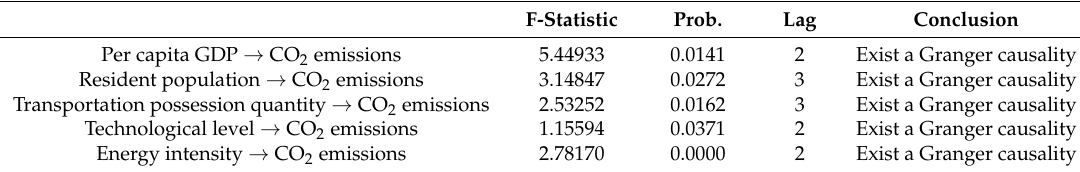
Table 3. Granger causality test results for CO 2 emissions and pre-selection factors.